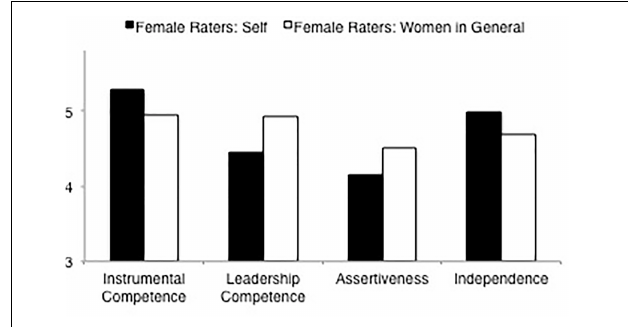
FIGURE 5 | Ratings of agency dimensions (instrumental competence, leadership competence, assertiveness, independence) by female raters rating self and women in general.